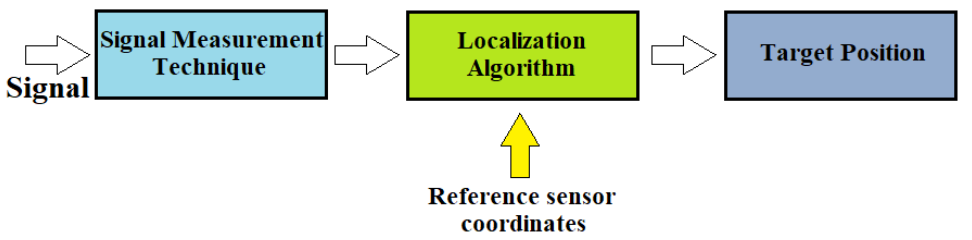
Figure 3. Diagram of the localization process.